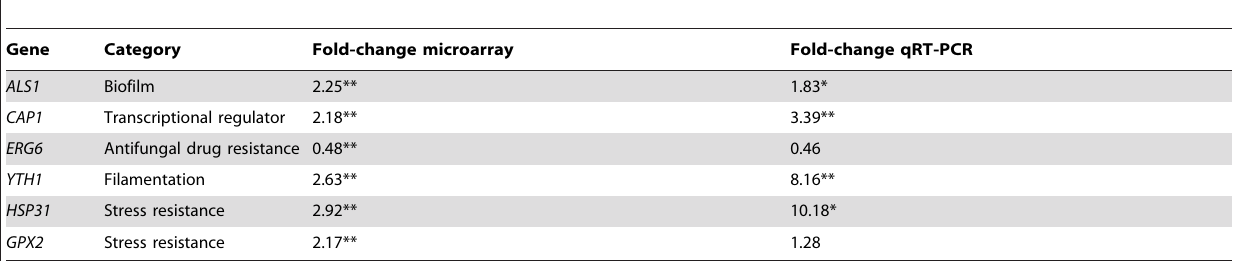
Table 4. Relative gene expression of C. albicans grown in spaceflight versus ground control conditions, as determined by microarray and qRT-PCR